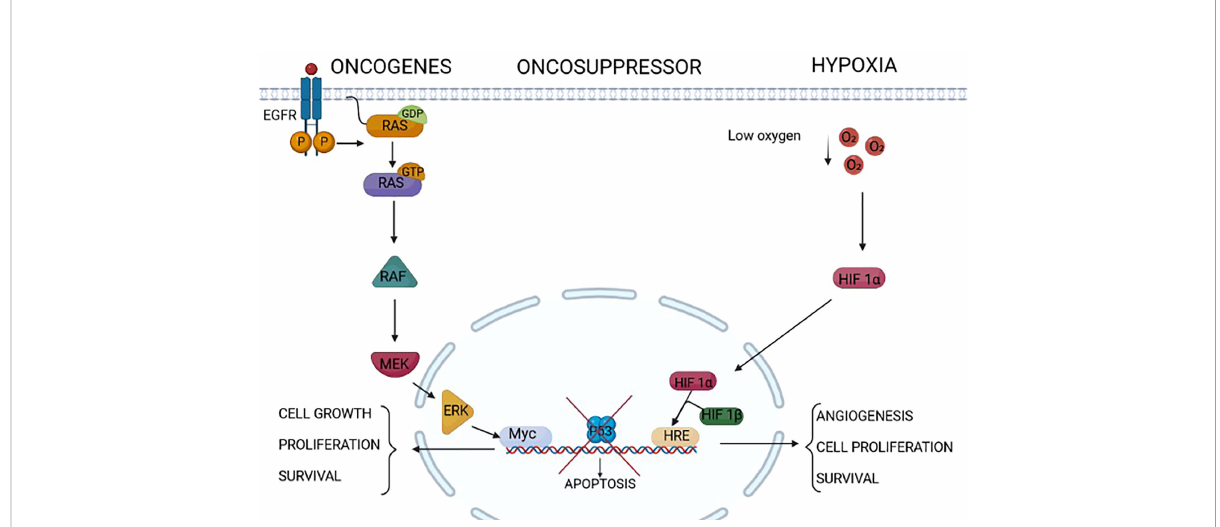
FIGURE 1 Endoplasmic reticulum (ER) stressors in cancer. Different factors/conditions related to cancer are considered ER stressors. The epidermal growth factor receptor family, composed of four members HER1, HER2, HER3, and HER4, is highly expressed in some cancers (for example, HER1/HER2 in gastric cancer and HER2 in breast cancer). The activation of HER2 and HER1 results in the activation of intracellular pathways including RAS/RAF/MEK/ERK, PI3K/AKT/TOR, Src family kinases, and STAT transcription factors that modulate survival, proliferation, mobility, and cancer cell invasiveness. Some tumors express RAS mutations that activate downstream signal transduction independently from upstream receptor activation. The increased cell proliferation relies on increased protein translation that is a source of ER stress in these tumors. On the same line, the lack of the activity of oncosuppressors such as p53 triggers uncontrolled cell proliferation and growth, which might induce ER stress. Extrinsic factors, i.e., independent from the genetic makeup of the tumor, as a low concentration of oxygen, hypoxia, might induce ER stress in tumors. Indeed, this is a common condition of solid tumors, which not only leads to the assembly of the two components HIF1alpha and HIF1beta of HIF1, rendering it an active transcription factor of genes involved in angiogenesis and cell proliferation, but also impairs the formation of post-translational disul fi de bonds in proteins, triggering ER